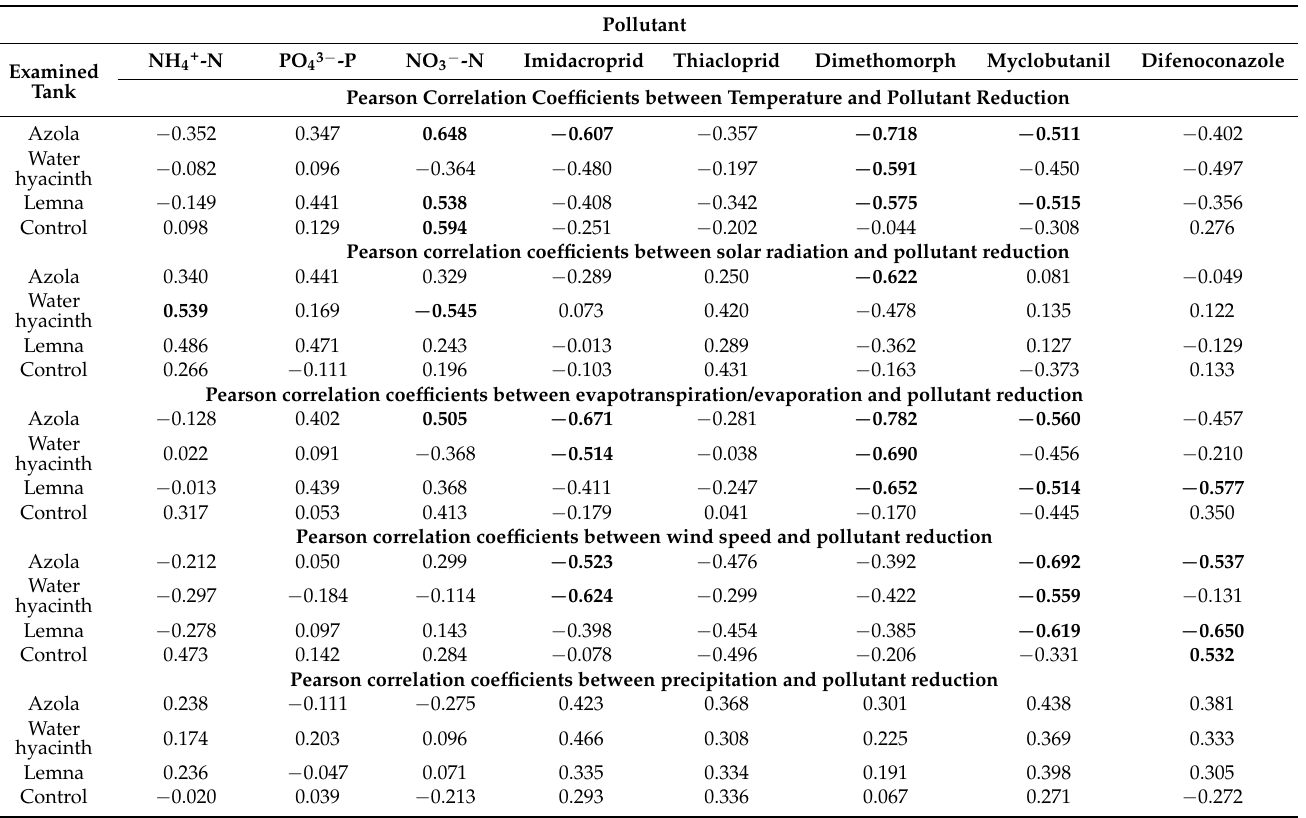
Table 6. Pearson correlation coefficients between meteorological variables and pollutant reduction rates per pollutant and examined tank. Bold values indicate a strong linear